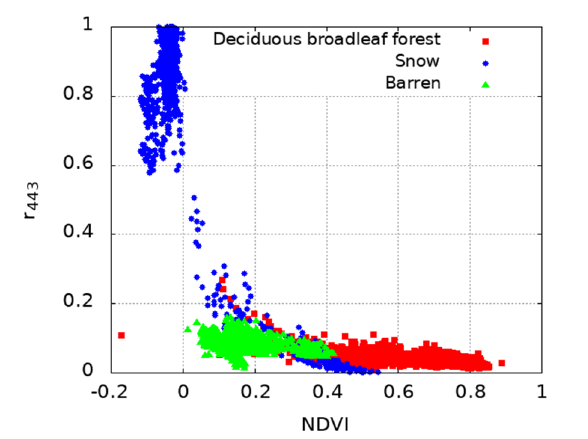
Figure 2. Scattergram of reflectance versus normalized difference vegetation index (NDVI) at the wavelength of 443 nm.